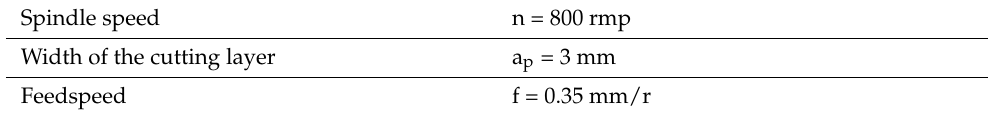
Table 6. Technological parameters of the cutting process—medium-precision machining. Spindle speed n = 800 rmp Width of the cutting layer a p = 3 mm